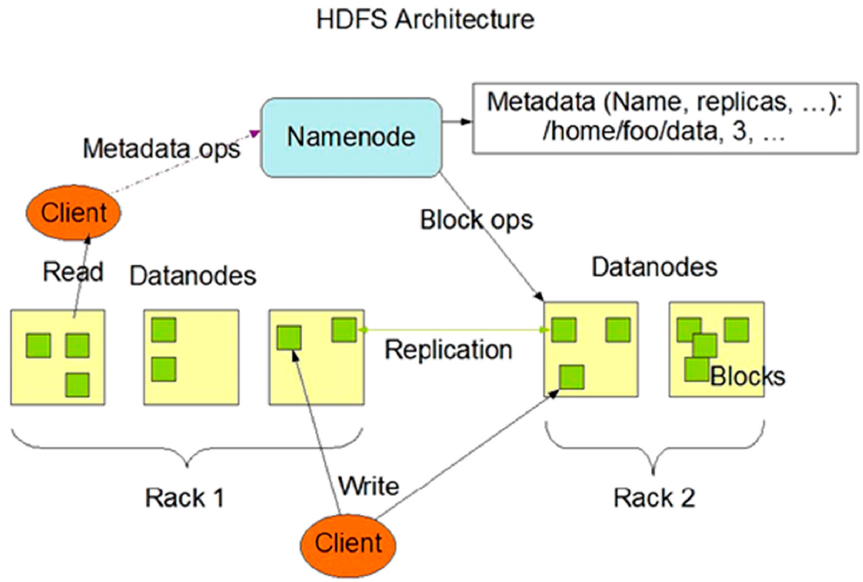
Figure 1. The architecture of Hadoop File System (HDFS).